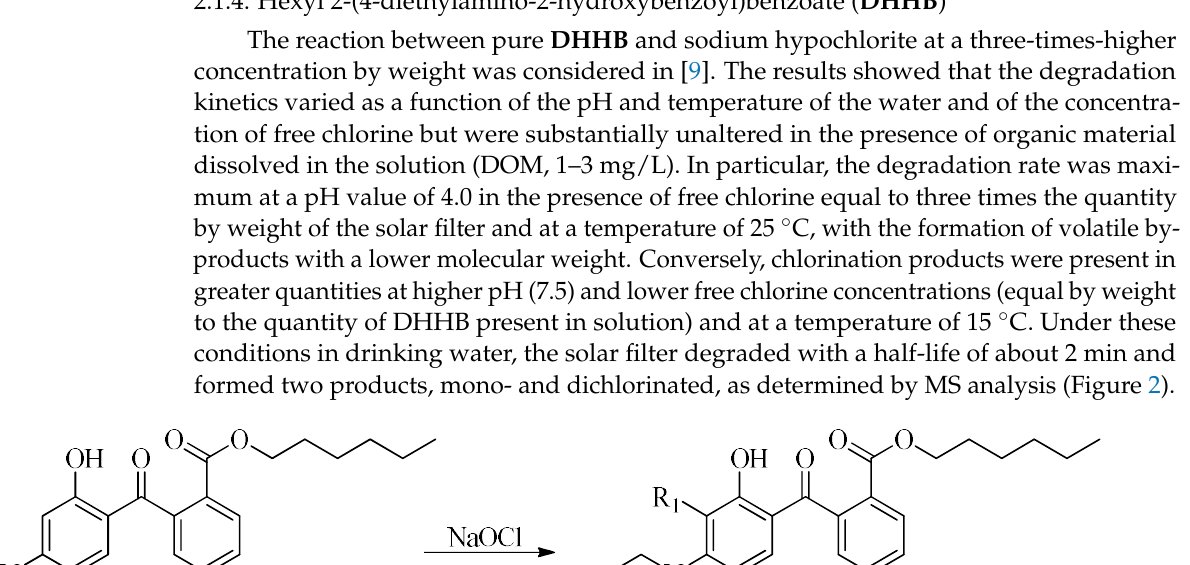
Scheme 5. Disinfection by-products from BP-8 chlorination.